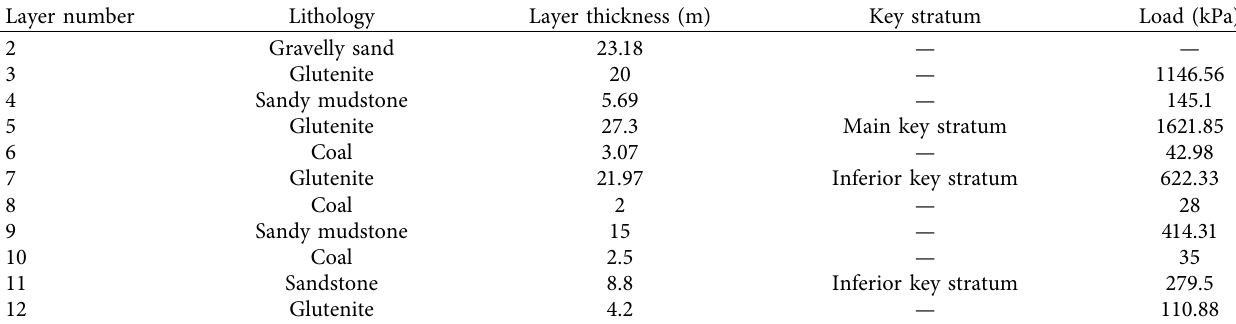
Table 2: Load of overlying strata and identification of key strata above coal seam.